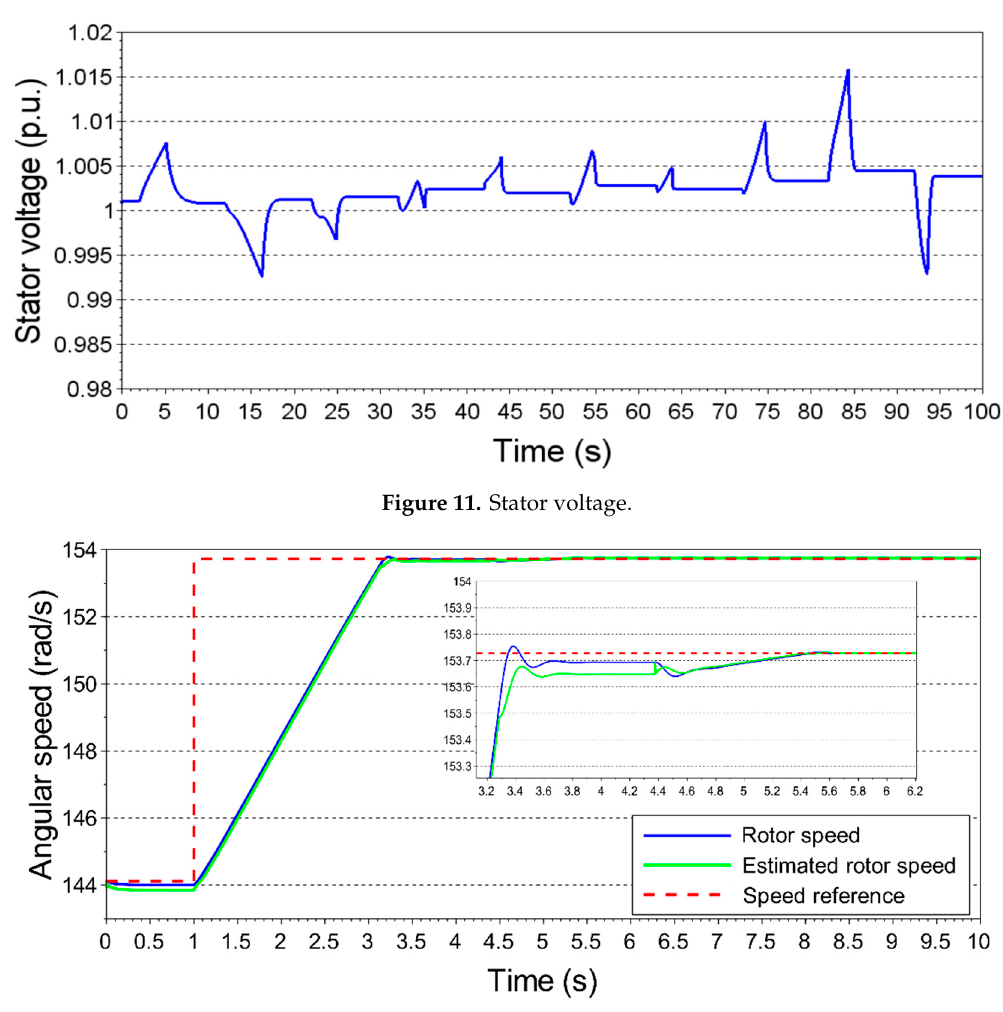
Figure 12. Estimated and actual rotor speed behavior of wrong and corrected magnetizing inductance